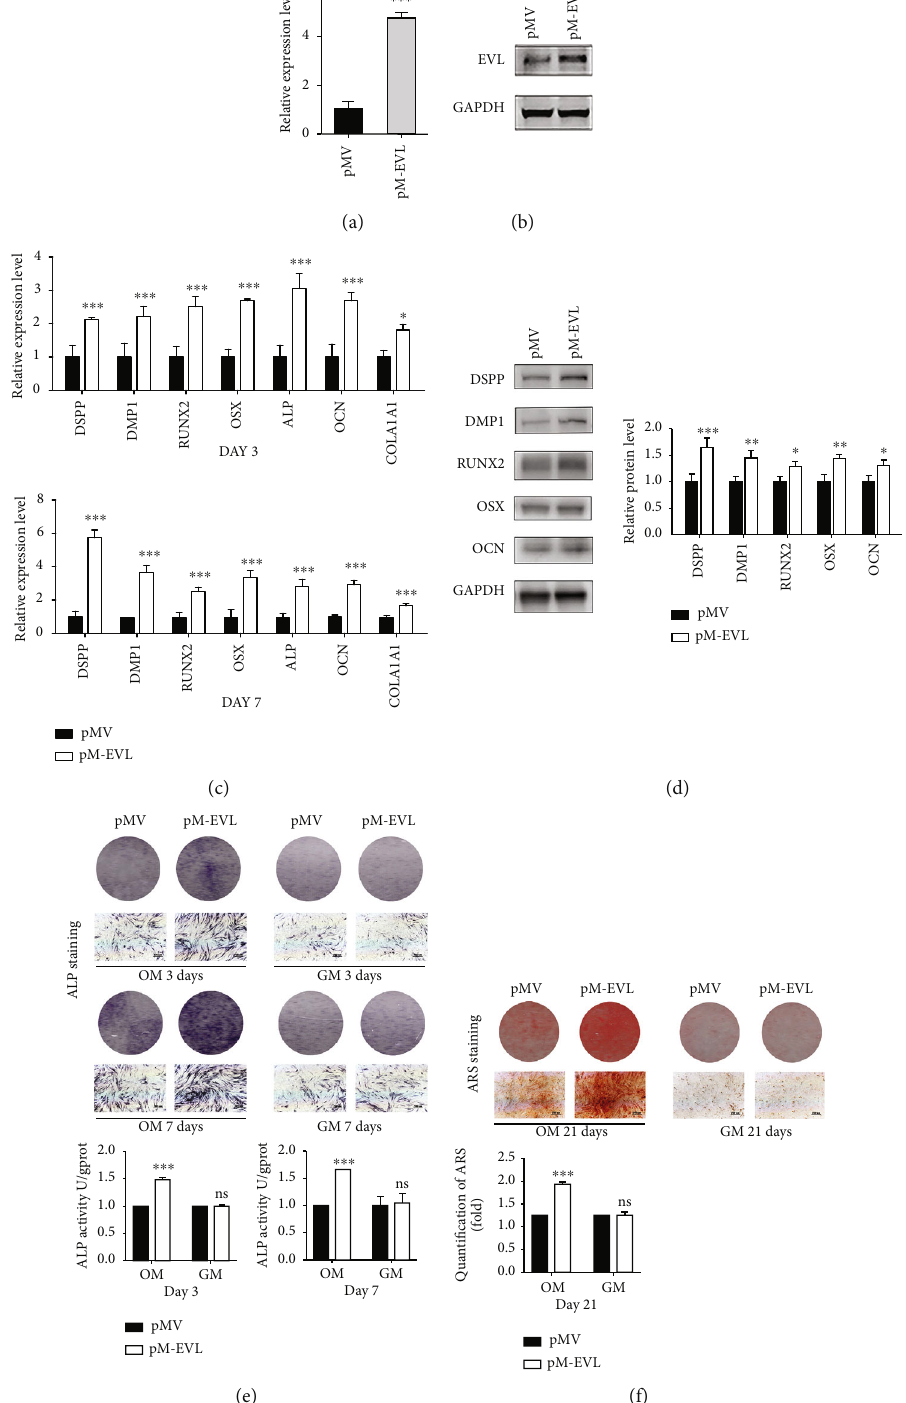
Figure 3: Overexpression of EVL promoted the osteo-/odontogenic di ff erentiation of hDPSCs. (a, b) Veri fi cation of the EVL overexpression e ffi ciency in hDPSCs transfected with pM-EVL or pMV by western blot and qRT-PCR. (c) The expression of DSPP, DMP1, RUNX2, OCN, and OSX in hDPSCs transfected with pM-EVL and pMV by western blot on the 7th day. (d) The expression of DSPP, DMP1, ALP, RUNX2, OSX, OCN, and COL1A1 were analyzed in hDPSCs transfected with pM-EVL and pMV by qRT-PCR on the 3rd and 7th day. (e) ALP staining and quantitative intracellular ALP activity were determined in hDPSCs transfected with pM-EVL and pMV and cultured in GM or OM on the 3rd and 7th day. (f) Extracellular calcium deposition was visualized by alizarin red staining on the 21st day. Released dye in alizarin red staining was quanti fi ed by measuring absorbance at 562 nm. GAPDH was used as an internal control in qRT-PCR and western blot analyses. Data are shown as the mean ± SD ( n = 3 ); ∗ P ≤ 0 : 05 , ∗∗ P ≤ 0 : 01 , ∗∗∗ P ≤ 0 : 001